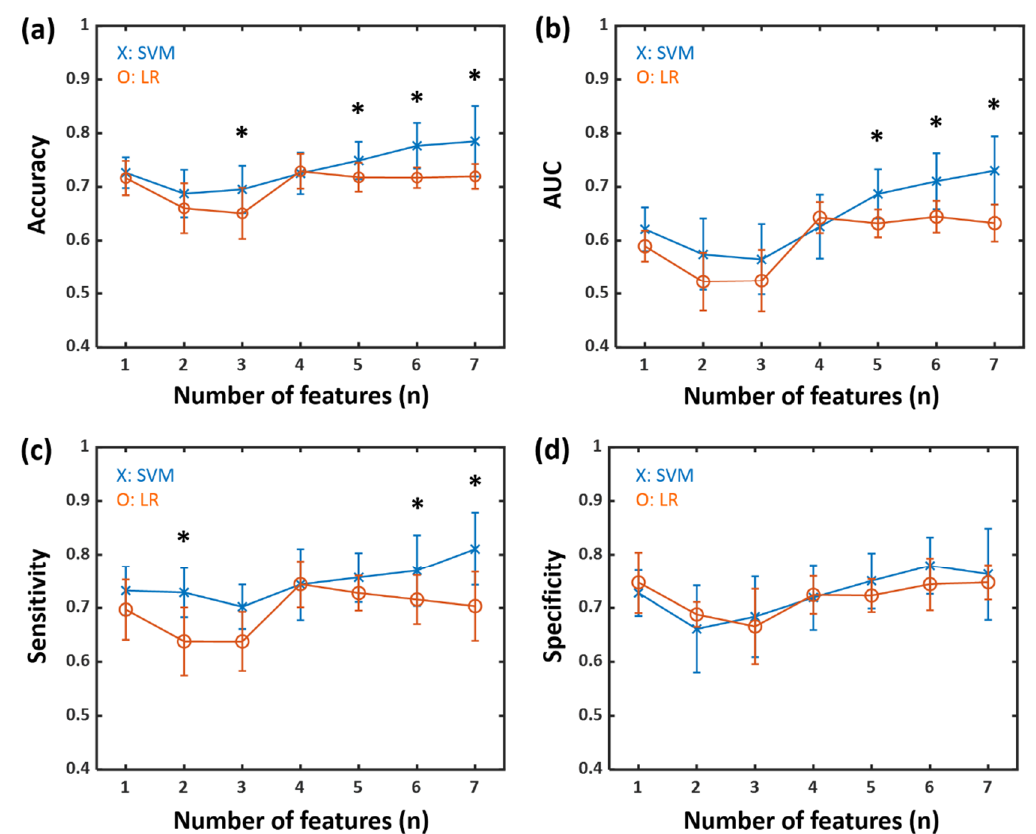
Figure 3. Performance of SVM and LR in classifying patients with early Parkinson’s disease (PD) and healthy controls (HC) using backward elimination of features. The results for SVM and LR are shown in regard to ( a ) accuracy, ( b ) area under the receiver operating curve (AUC), ( c ) sensitivity, and ( d ) specificity. The features were included as the training set from the region of interest with the highest F-score to the region of interest with the lowest F-score. Asterisk (*) shows significance ( p < 0.05). LR = logistic regression, SVM = support vector machine.